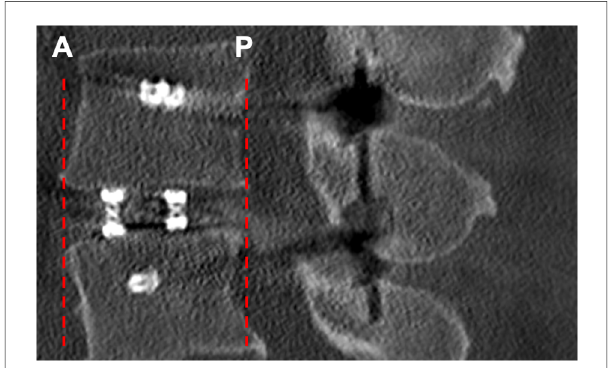
FIGURE 2 Radiographic evaluation of cage placement. Figure 2 shows an intraoperative CT-scan after 360-degree instrumentation of the lumbar spine in a sagittal view. Cage placement was evaluated in anterior ( A ) and posterior ( P ) orientation in relation to the limits of the upper and lower endplate of the adjacent